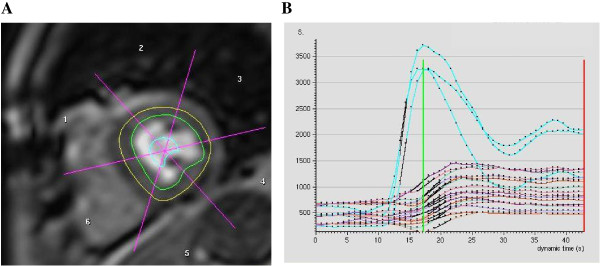
Semi-quantitative perfusion analysis. Semi-quantitative perfusion analysis: A, Manual tracing of the endocardial (green) and epicardial (yellow) borders and division of the LV myocardium into 6 segments, and B, Generation of signal intensity (y axis) vs. time (x axis) curves for each myocardial segment and LV (blue). Maximal upslopes for each myocardial segment, normalized to LV input, with the myocardial perfusion reserve index (MPRi) as the ratio of stress to rest upslopes.